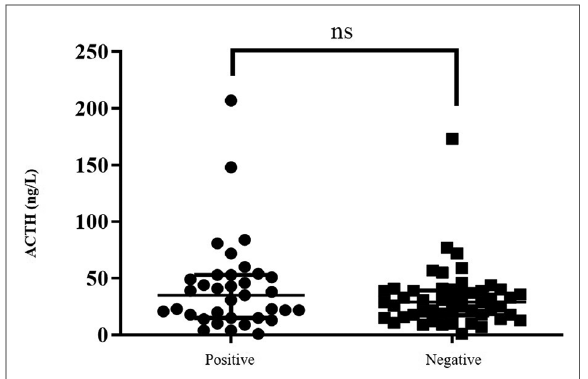
FIGURE 2 Morning plasma ACTH levels according to the result of the LD-SST. Distribution of ACTH dosages is represented with median and interquartile range depending on the results of the LD-SST. LD- SST was considered positive when cortisol at T20 raised above 500 nmol/L otherwise it was considered negative. Association between ACTH and GI-AI did not reach statistical signi fi cance using Analysis Of Variance (ANOVA, p =0.18, ns).